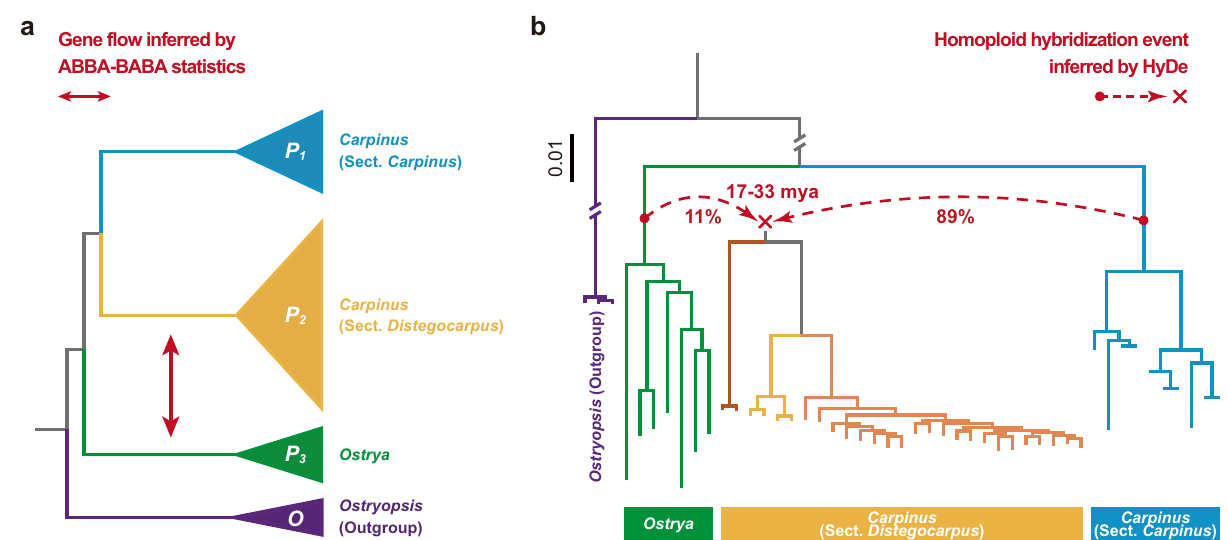
Fig. 4 ABBA-BABA test and HyDe analysis using indels from population genomic data. a ABBA-BABA test revealed the ancient gene fl ow between Ostrya and sect. Distegocarpus . Information for the lineages used was shown in the fi gure. b Homoploid hybrid origin of sect. Distegocarpus inferred by HyDe analysis. The red arrows (indicating the putative parents and hybrid lineages) and the red numbers (genomic contribution) indicate the results produced by HyDe. The time of homoploid hybrid origin was inferred by the previously dated divergence times between the three lineages (see in Fig. 2c, d). ABBA- BABA test and HyDe analysis were both performed at the population level, with the information from all individuals per population imputed together.